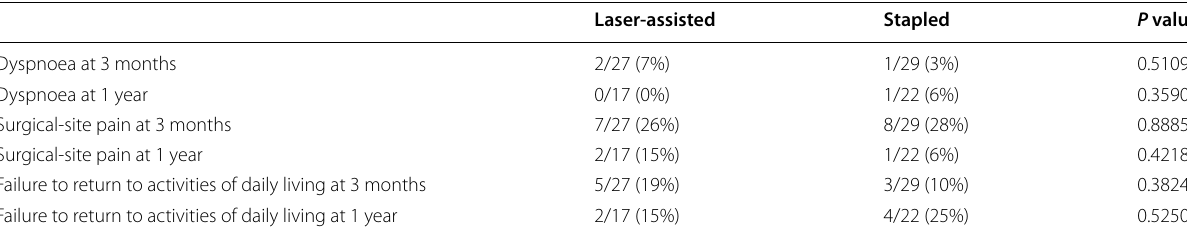
Table 5 Short- and medium-term patient-centred